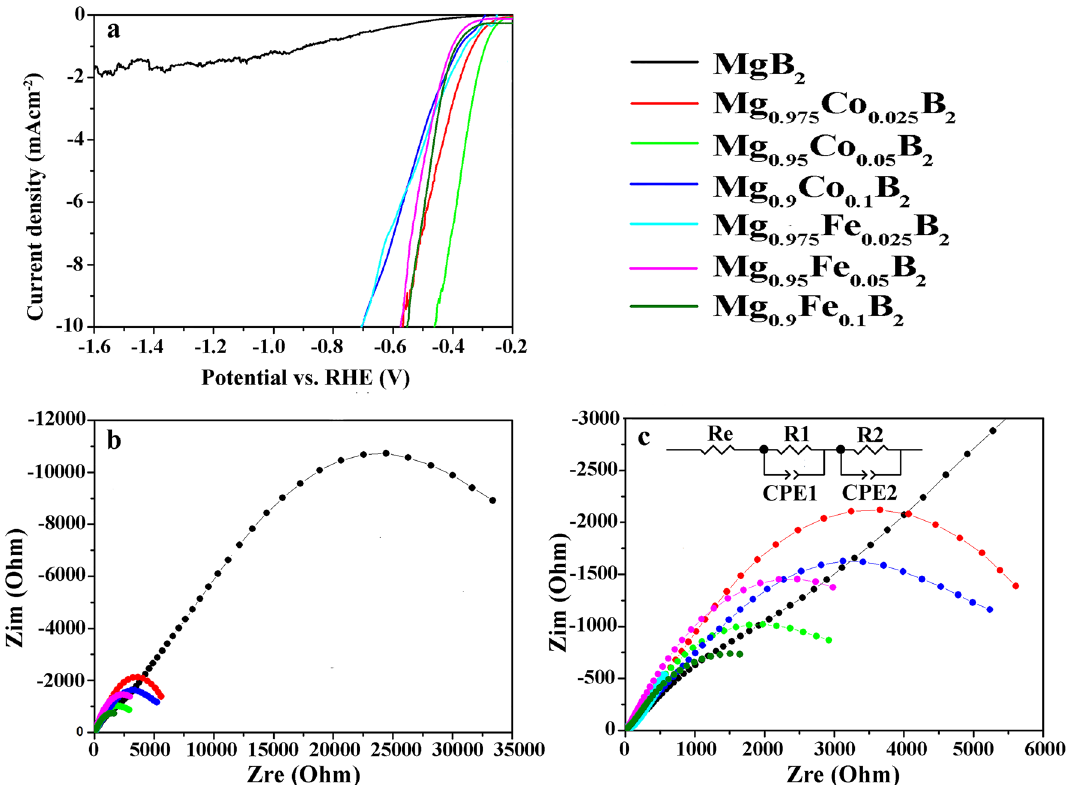
Figure 7. Polarization curves of ( a ) the HER reaction of pure and doped MgB 2 , ( b , c ) Nyquist plots measured at OCP in supporting electrolyte of 1 M high-frequency R-CPE element is correlated with the porosity whereas the low-frequency element is related to the kinetics of the HER. In principle, the formation of two semicircles on the Nyquist plot corresponds to the geometric kinetic origin. The first semicircle is related to geometric and the second one is related to kinetic. The diameter of the semicircles represents the charge transfer resistance. Both the transfer of electronic charge on the electrode/electrolyte inter- face and the charge transfer in the host lattice control the electrochemical reactions at the electrodes. The acquired results for the Nyquist equation by Z-view software are summarized in Table 2 (detailed data in Table S3). The results support that metal doping of MgB 2 has dramatically decreased both R1 (charge-transfer resistance of the